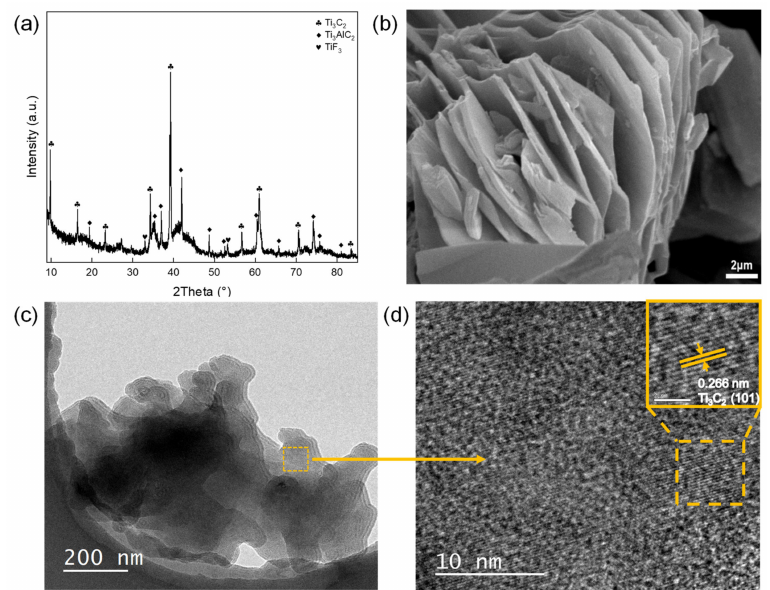
Figure 1. Characterizations of the as-synthesized ML-Ti 3 C 2 : ( a ) X-ray diffractometer (XRD) patterns of as-synthesized ML-Ti 3 C 2 , ( b ) Scanning electron microscopy (SEM) images, ( c ) transmission electron microscopy (TEM) image, and ( d ) High resolution TEM